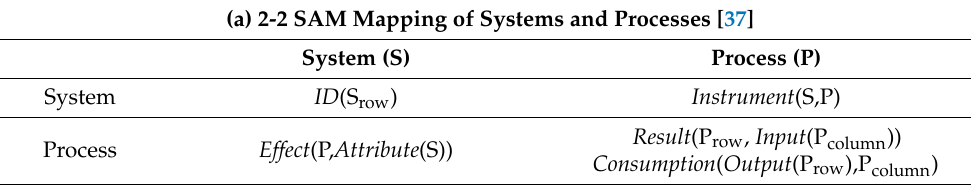
Table 1. System Architecture